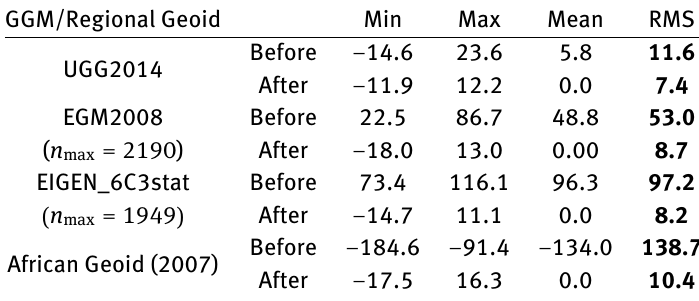
Table 5: The GNSS/levelling residuals over the 10 FBMs before and after the 4-parameter fit (Unit: cm) GGM/Regional